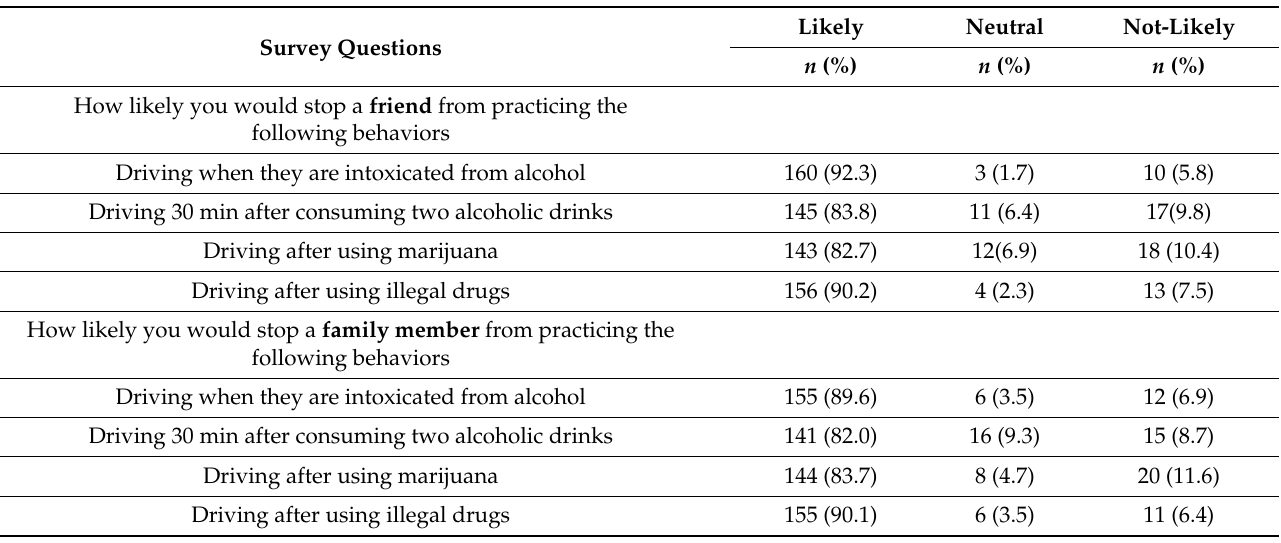
Table 5. First-time participants likelihood of stopping a friend or family member practicing unsafe driving behaviors ( n =